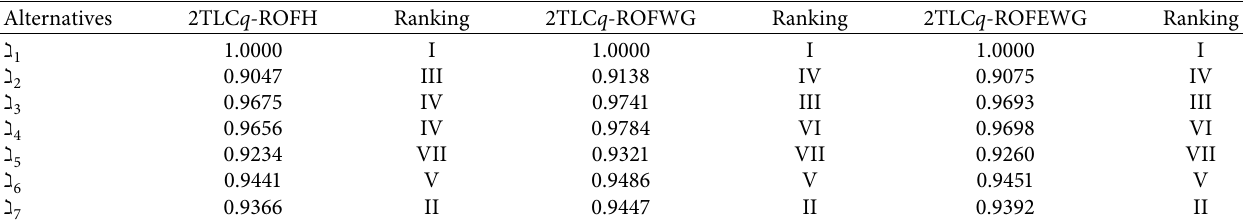
Table 16: Evaluation outcomes by utilizing different aggregation operators based on the 2TLC q -ROFHWG operator. Alternatives 2TLC q -ROFH